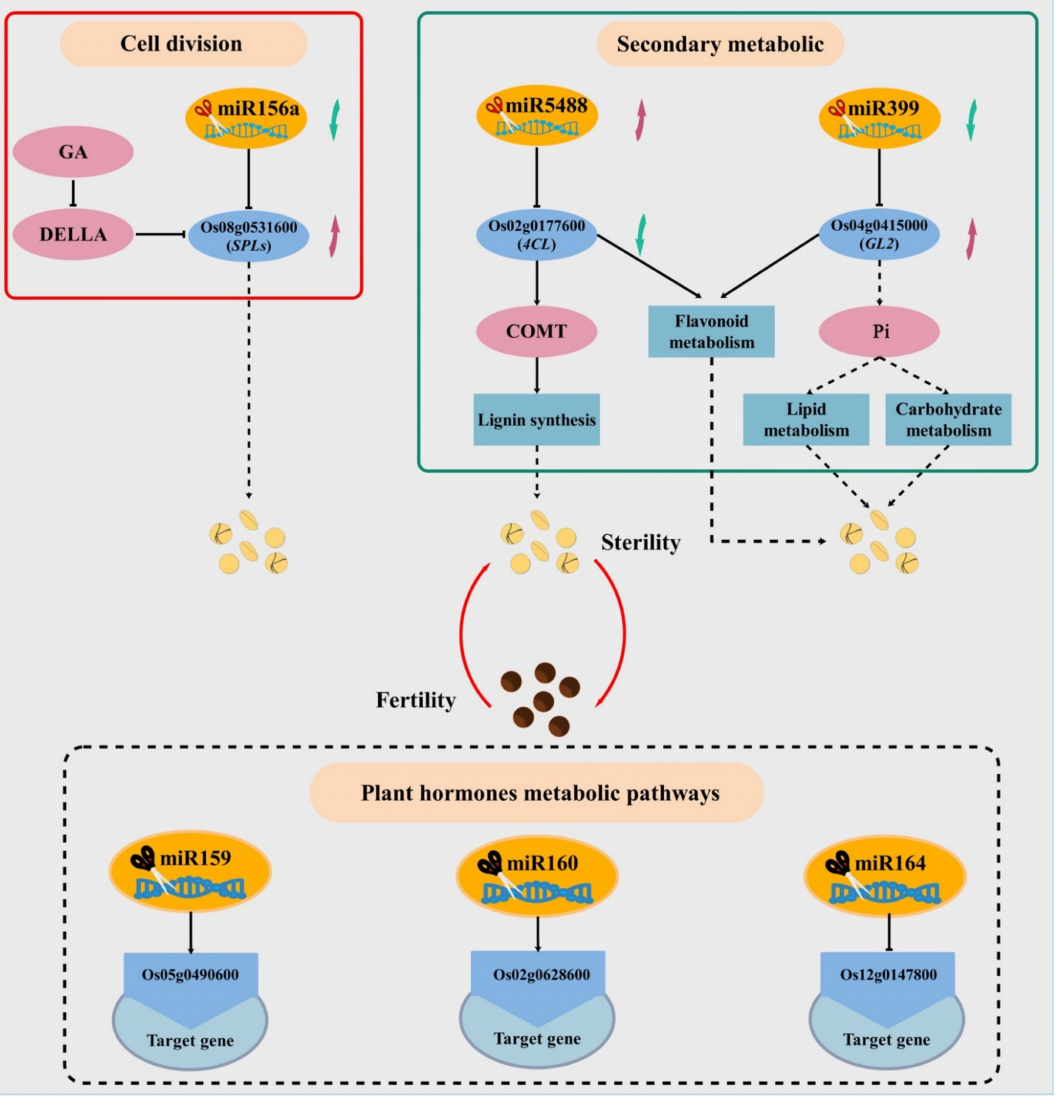
Figure 11. Model of miRNA and target gene regulation of male sterile changes in PA64S. The black dashed box indicates the miRNA and its target gene that did not reach a significant difference. The red arrow indicates the upregulated miRNA or target genes, and the green arrow indicates the downregulated miRNA or target